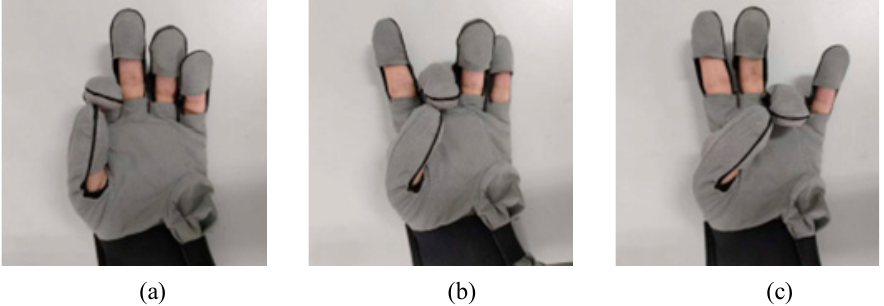
Figure 12. Finger training effect. ( a ) Index finger training; ( b ) Mid-finger training; ( c ) The ring finger training.